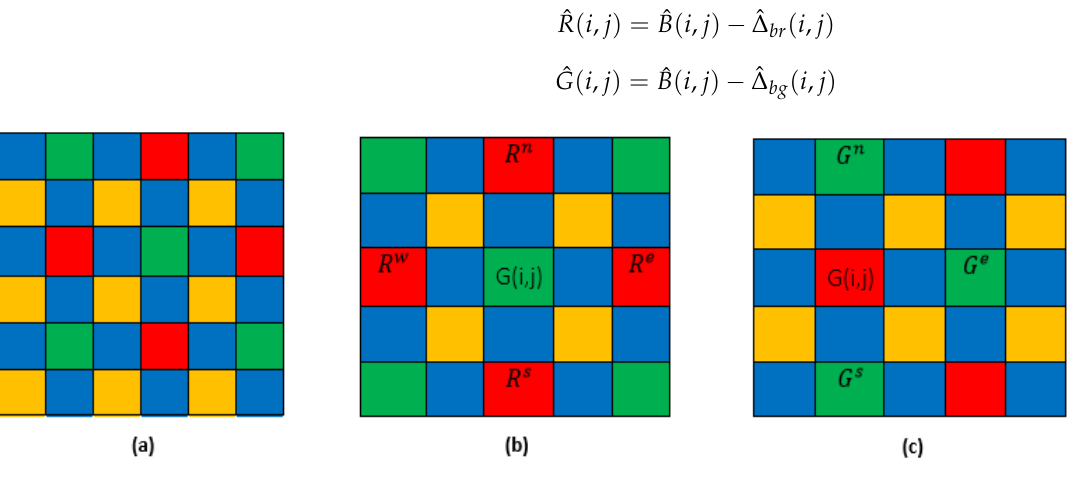
Figure 7. ( a ) Four ‐ band MSFA ( b ) neighborhood of G ‐ band ( c ) neighborhood of R ‐ band.